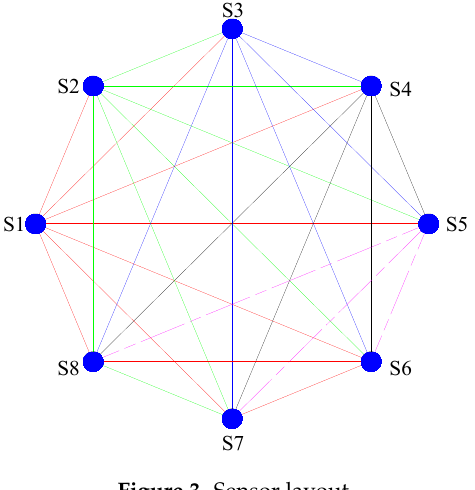
Figure 3. Sensor Figure 3. Sensor layout.